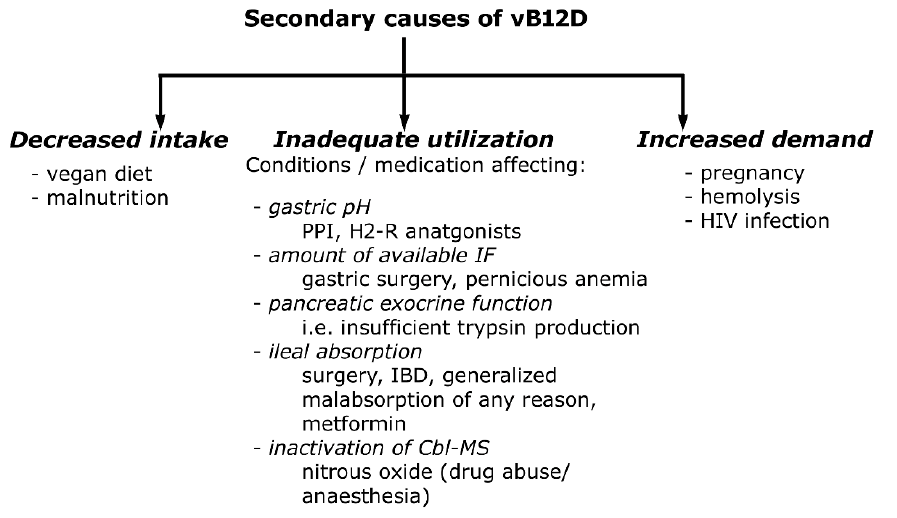
Figure 4. Secondary causes of vB12 deficiency. PPI proton pump inhibitor; H2-R histamine2-receptor; IBD inflammatory bowel disease; HIV human immunodeficiency virus.